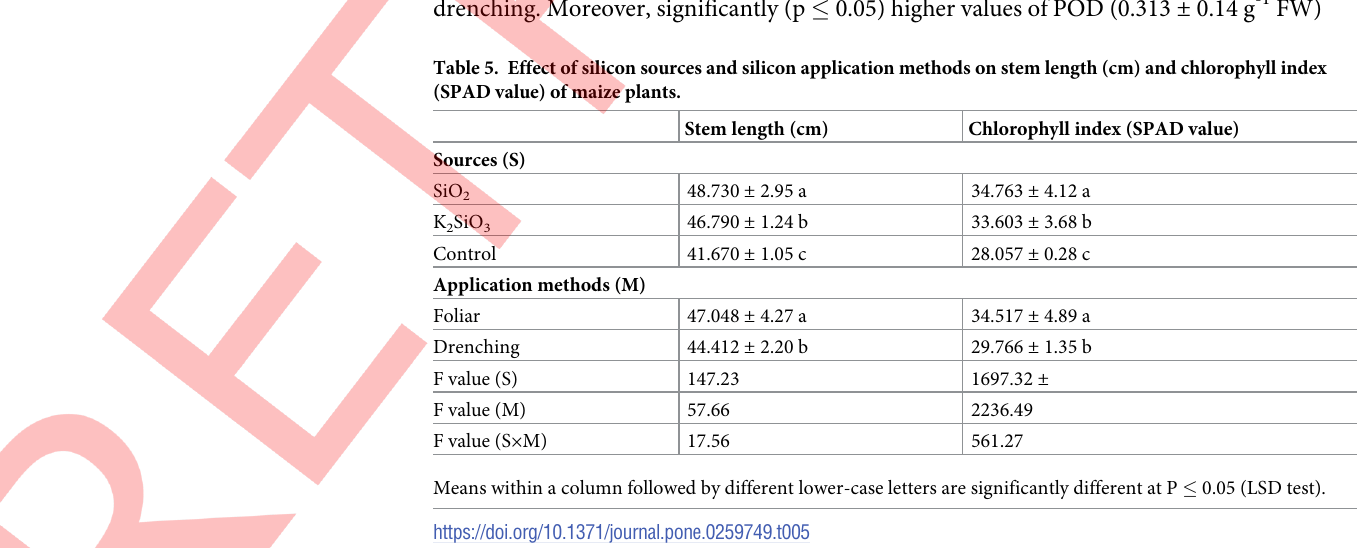
Table 5. Effect of silicon sources and silicon application methods on stem length (cm) and chlorophyll index (SPAD value) of maize